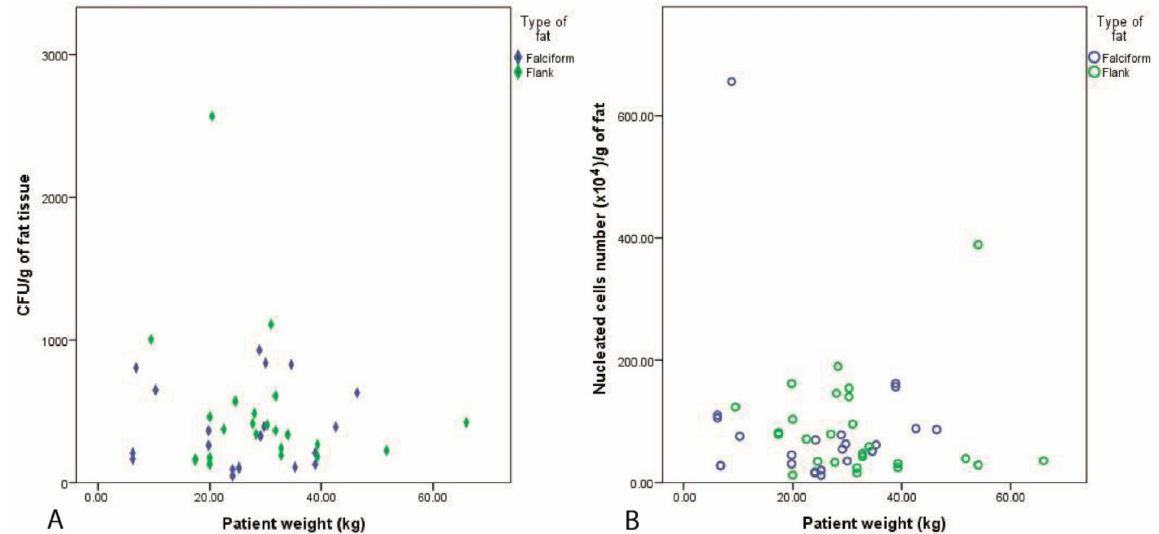
Figure 2. Pearson’s correlation demonstrating no significant difference in variability of nucleated cells and CFU/g of cells vs. weight of the patient in the fat harvested from the falciform and flank regions. Weight of the patient vs. CFU/g for the fat harvested from the falciform ( p = 0.890) and flank regions ( p = 0.333) ( A ). The weight of the patient vs. nucleated cells in stromal vascular fractions (SVFs) per gram of fat was not significantly different between the two harvest sites: flank ( p = 0.874) and falciform ( p = 0.966) ( B ).